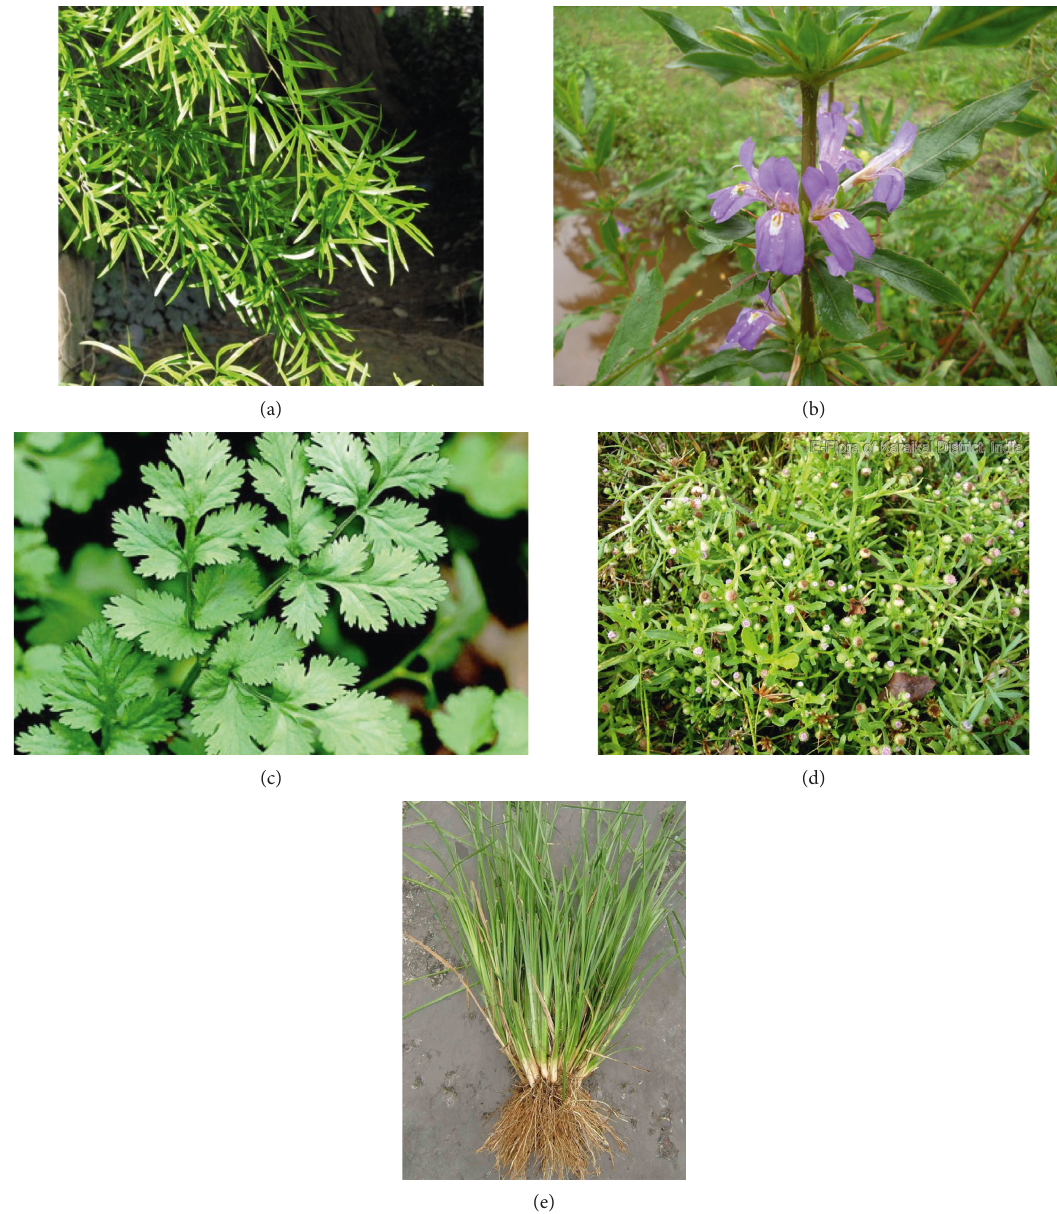
Figure 1: Photographs of plants used in the study. (a) Botanical name: Asparagus falcatus ; local name: hathawariya; family: Liliaceae. (b) Botanical name: Asteracantha longifolia; local name: neeramulliya; family: Acanthaceae. (c) Botanical name: Coriandrum sativum ; local name: koththamalli; family: Umbelliferae. (d) Botanical name: Epaltes divaricata ; local name: heen mudamahana; family: Compositae. (e) Botanical name: Vetiveria zizanioides ; local name: sewendara; family: